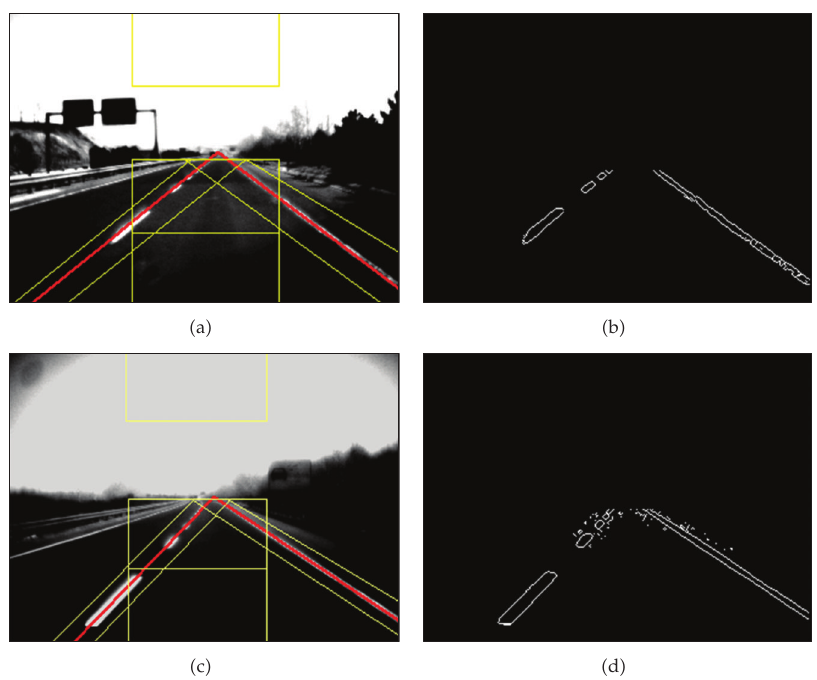
Figure 3: Image captured after the CCD parameters regulation and its segmentation